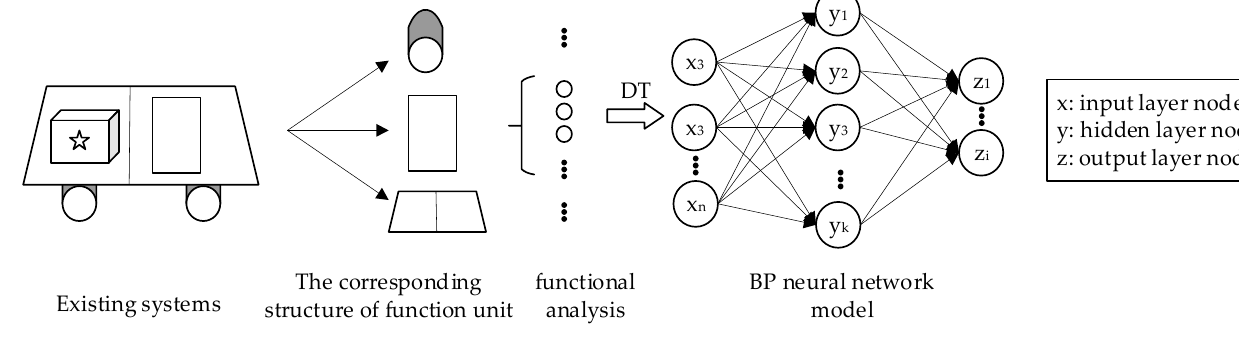
Figure 7. Complexity prediction model.